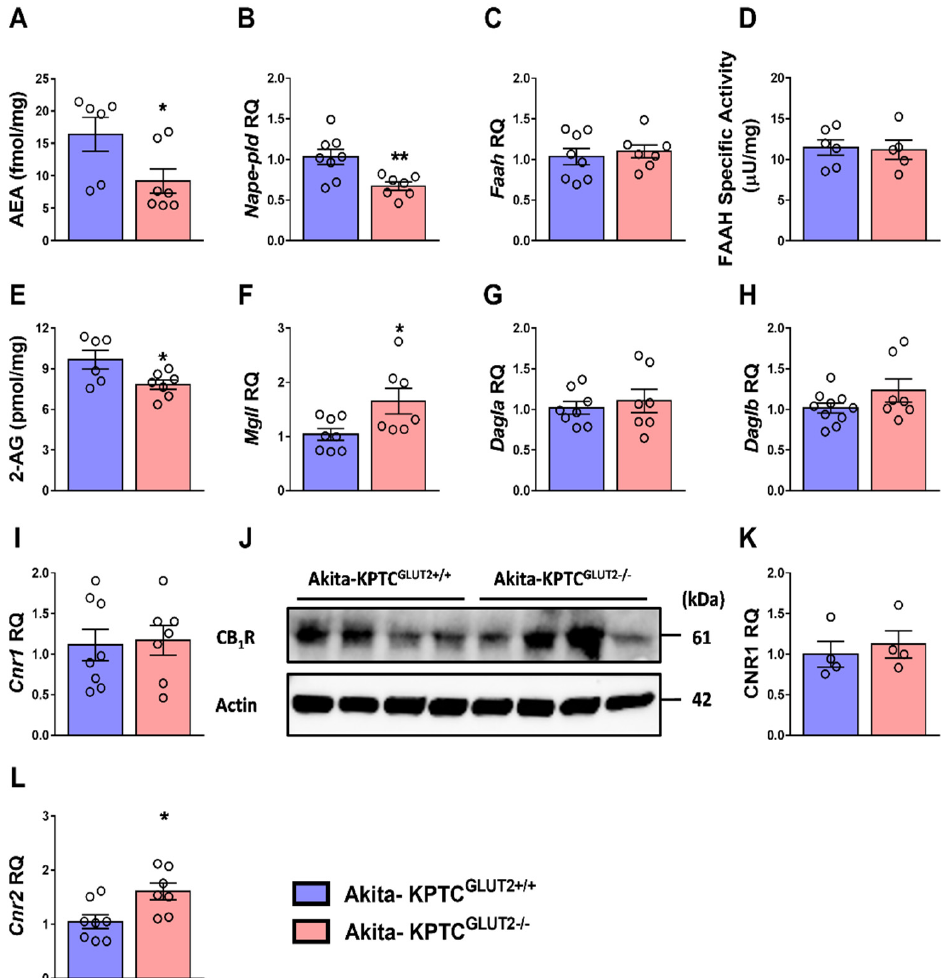
Figure 4. Reduced endocannabinoid ‘tone’ in Akita-KPTC GLUT2 − / − mice. Decreased levels of LC- MS/MS measured kidney endocannabinoids, AEA and 2-AG, from Akita-KPTC GLUT2 − / − mice, compared to Akita-KPTC GLUT2+/+ WT animals ( A , E ), corresponding to the decreased kidney Nape-pld ( B ) and no change in Faah mRNA levels ( C ), and FAAH activity ( D ) as well as increased Mgll ( F ) and no changes in Dagla/b mRNA levels ( G , H ). Kidney CB 1 R ( Cnr1 ) mRNA ( I ) and protein levels are shown in a representative immunoblot ( J ) and quantification ( K ). Kidney CB 2 R ( Cnr2 ) mRNA ex-